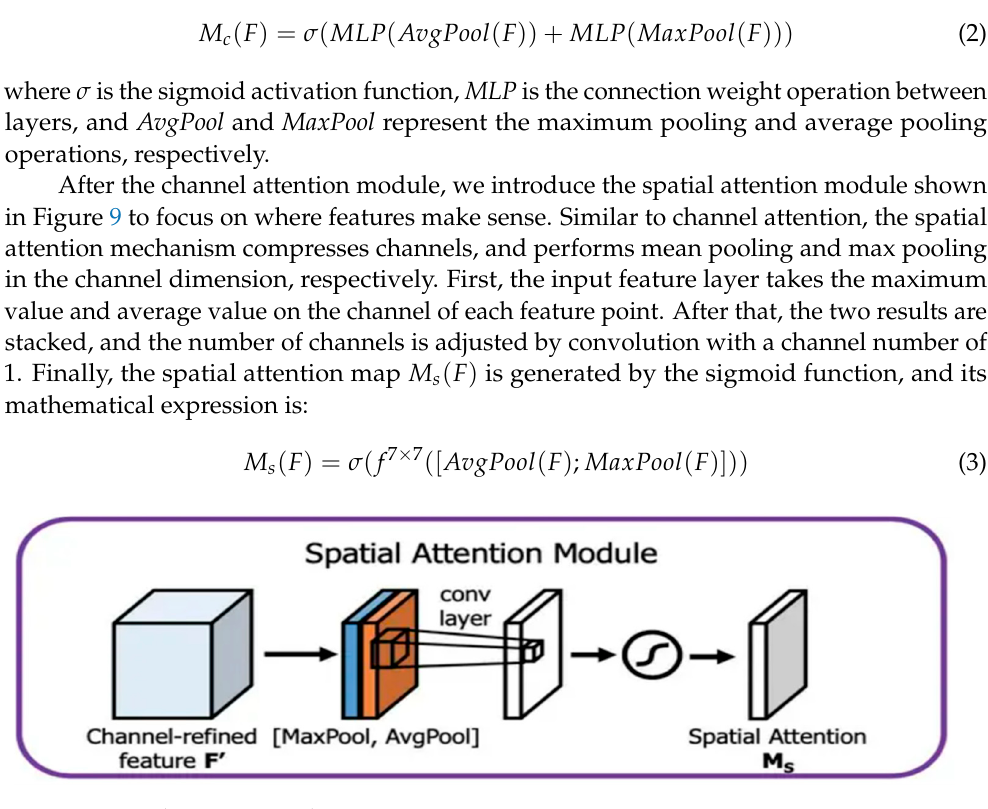
Figure 9. Spatial attention mechanism.